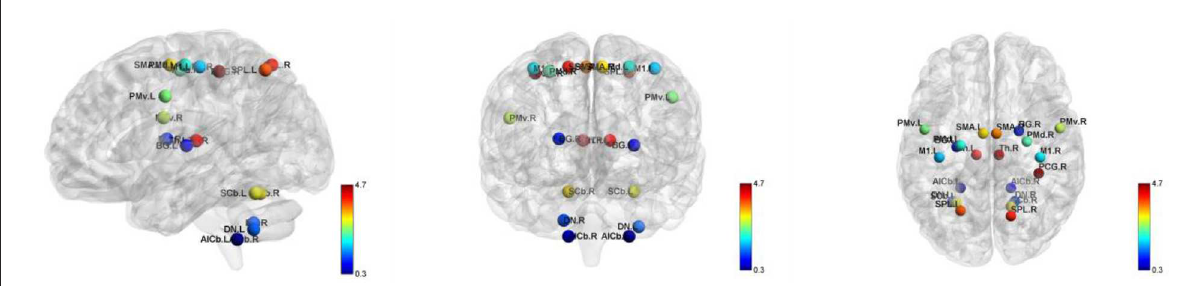
FIGURE1 Locations of the nodes belonging to the motor execution network. AICb, anterior inferior cerebellum; BG, basal ganglia; DN, dentate nucleus; L, left; M1, primary motor cortex; PCG,postcentral gyrus; PMd, dorsolateral premotor cortex; PMv, ventrolateral premotor cortex; R, right; SCb,superior cerebellum; SMA, supplementary motor area; SPL, superior parietal lobule; Th,